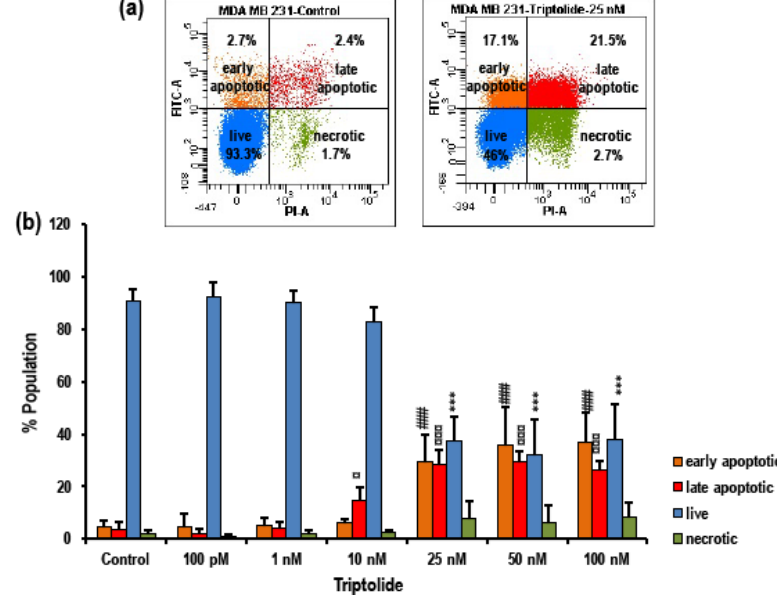
Figure 3. Effect of triptolide on cell death/apoptosis in MDA-MB-231 cells. ( a ) Representative scatter plots illustrating the live, early and late apoptotic, and necrotic cells in the untreated control and 25 nM triptolide-treated cells. ( b ) Bar graph shows consolidated data of live, early and late apoptotic, and necrotic population of control vs treated group. There is a significant increase in the apoptotic